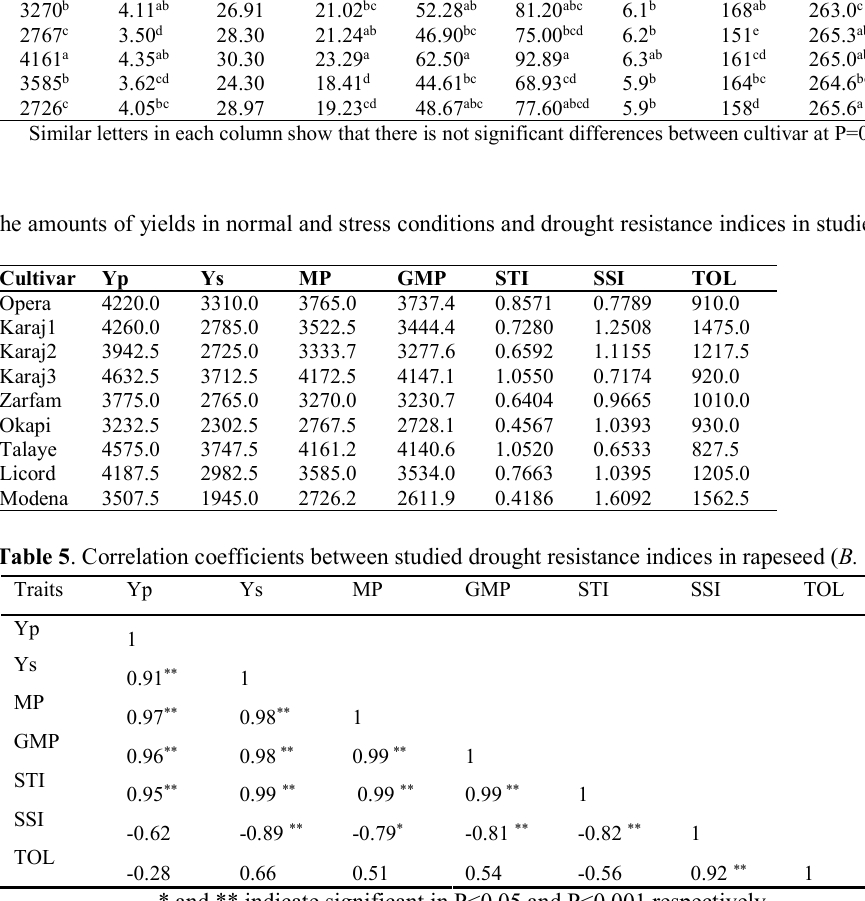
Table 3. Mean comparison of studied rapeseed cultivars for different traits in Duncan's new multiple range test (DMRT) method. Where plant height (PH), days to maturity (DTM), pods per main branch (PPMB), pods per sub- branch (PPSB), pods per plant (PPP), seed per pod (SPP), 1000 seeds weight (DSW) and pod length (PL) Cultivar